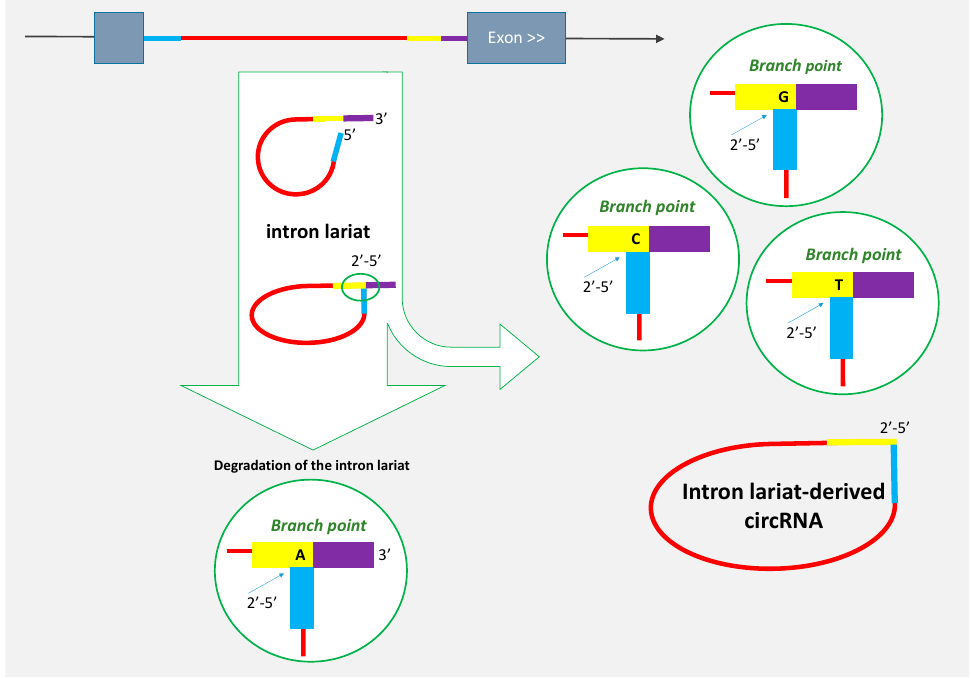
Figure 1. Genesis of lariat-derived circRNA. When intron lariats escape degradation through failure of intron debranching, they can become circRNA precursors. The intron excision from pre-mRNA releases a lariat molecule, in which the branch point nucleotide, predominantly an adenosine, is linked 2 ′ –5 ′ to the 5 ′ end of the intron [15,16]. The lariat debranching enzyme is hypothesized to be incapable of hydrolyzing the 2 ′ –5 ′ bond when the branch point nucleotide is not an ‘A’ [15].